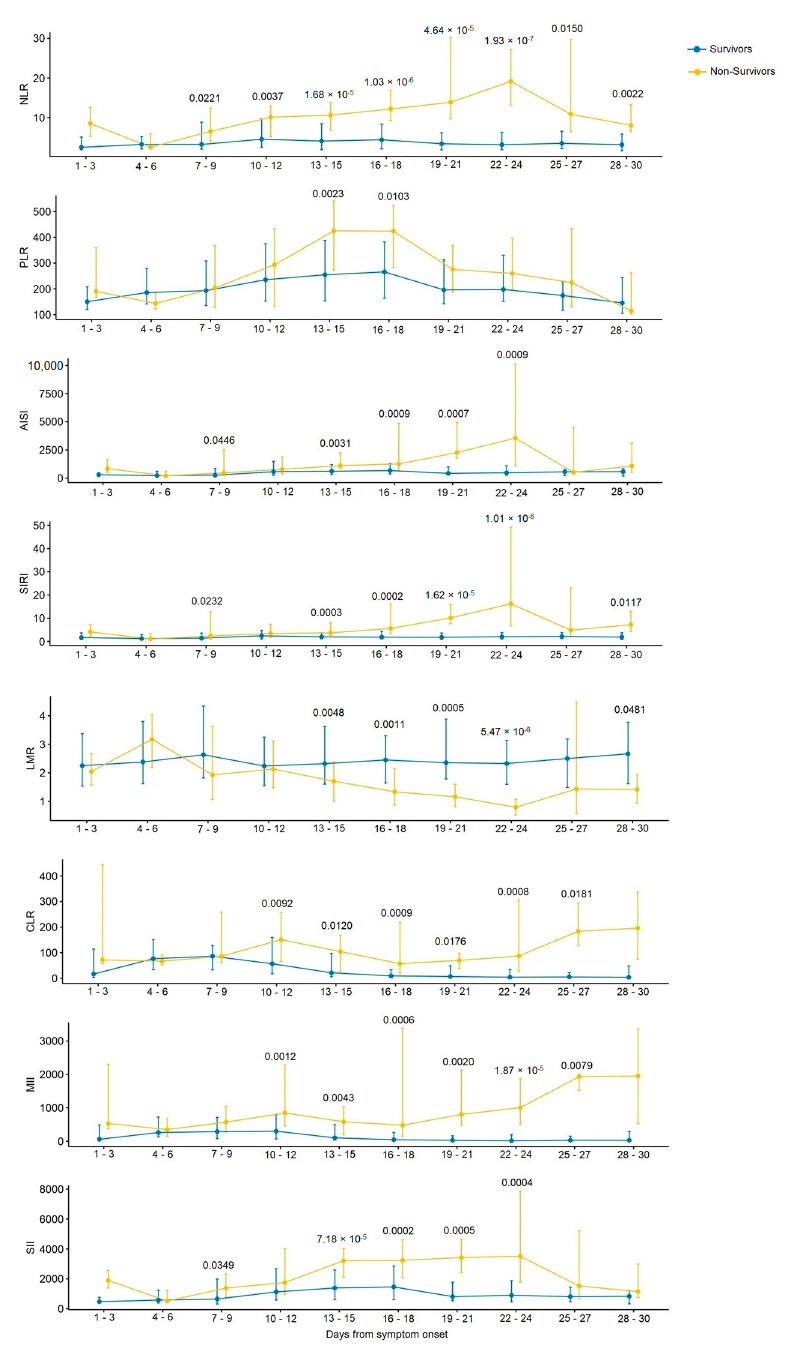
Figure 2. Serial changes in blood-cell-count- and CRP-derived inflammatory indices in COVID-19 patients. p -values less than 0.05 are